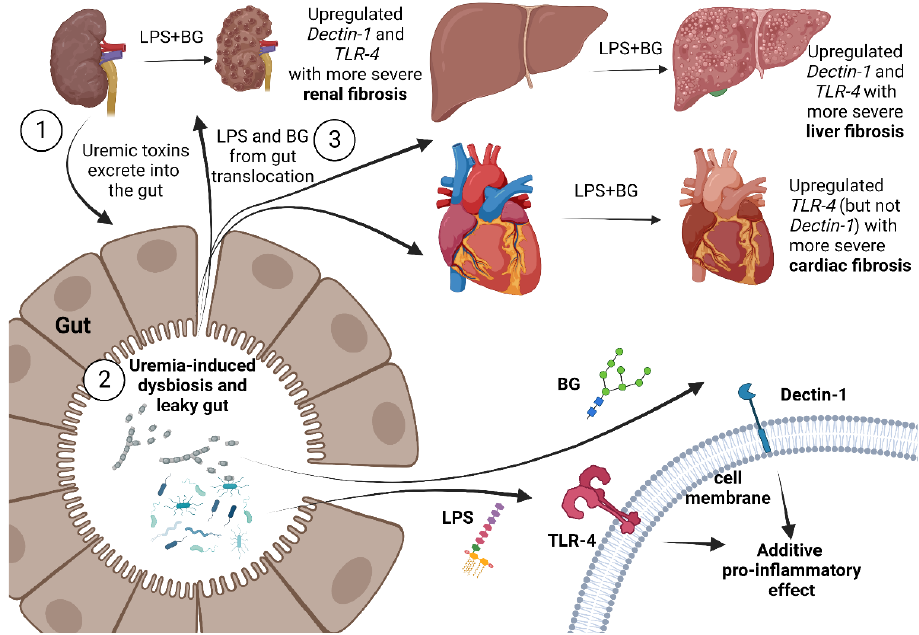
Figure 8. The proposed working hypothesis of the enhanced fibrosis from chronic kidney disease through leaky-gut-induced pro-inflammation that is activated by lipopolysaccharide (LPS) together with (1 → 3)- β -D-glucan (BG). Firstly (1), the increased uremic toxins in the intestine, and the substitution of kidney excretion, affects gut organisms and causes the intestinal barrier defect. Secondly (2), the LPS and BG from the gut translocate into the blood (leaky gut). Thirdly (3), LPS and BG additively activate pro-inflammation in several organs, partly through the activation of Toll-like-receptor 4 (TLR-4; LPS receptor) and Dectin-1 (BG receptor). The enhanced inflammatory responses from the leaky gut during uremia possibly worsen several uremic complications. The diagram was created using Biorender.com.